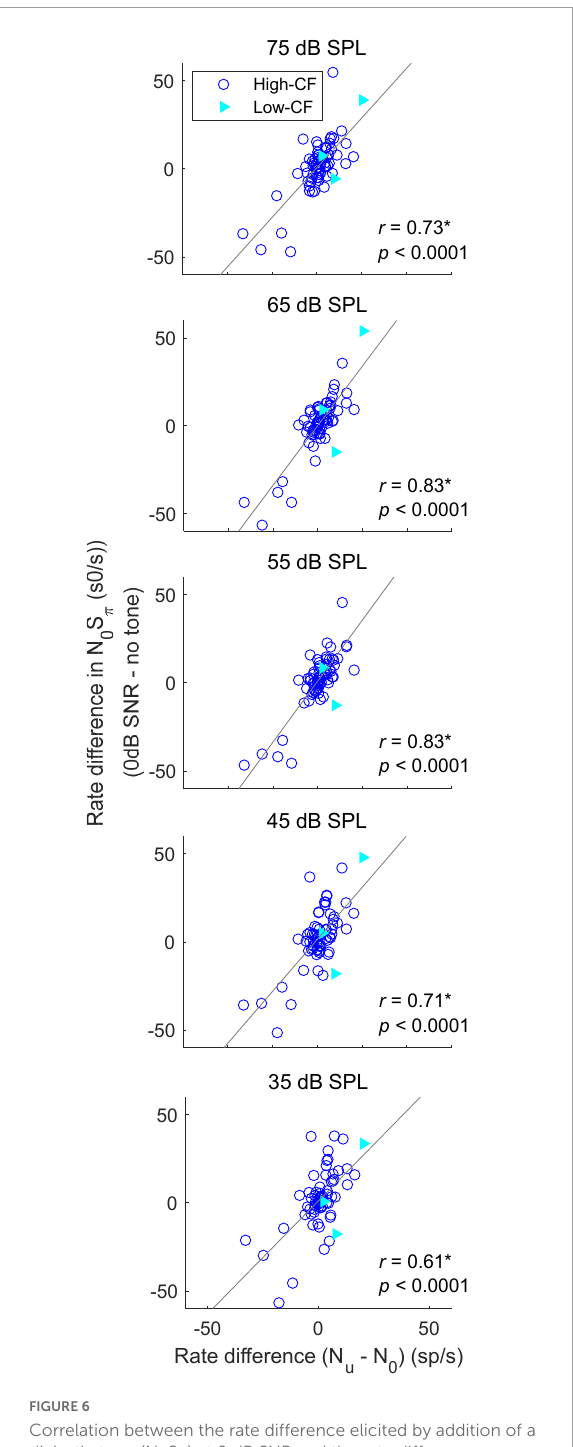
FIGURE6 Correlation between the rate difference elicited by addition of a dichotic tone (N 0 S π ) at 0 dB SNR and the rate difference between responses to N 0 and N u conditions. Correlation coefficients and p -values are shown; a star indicates that the correlation coefficient was significant after Bonferroni correction ( p < 0 . 0014 ) . Neurons with CF below 1.5 kHz (low–CF) are shown in filled triangles, whereas neurons with CF above 1.5 kHz (high–CF) are shown in open circles. Solid lines show linear